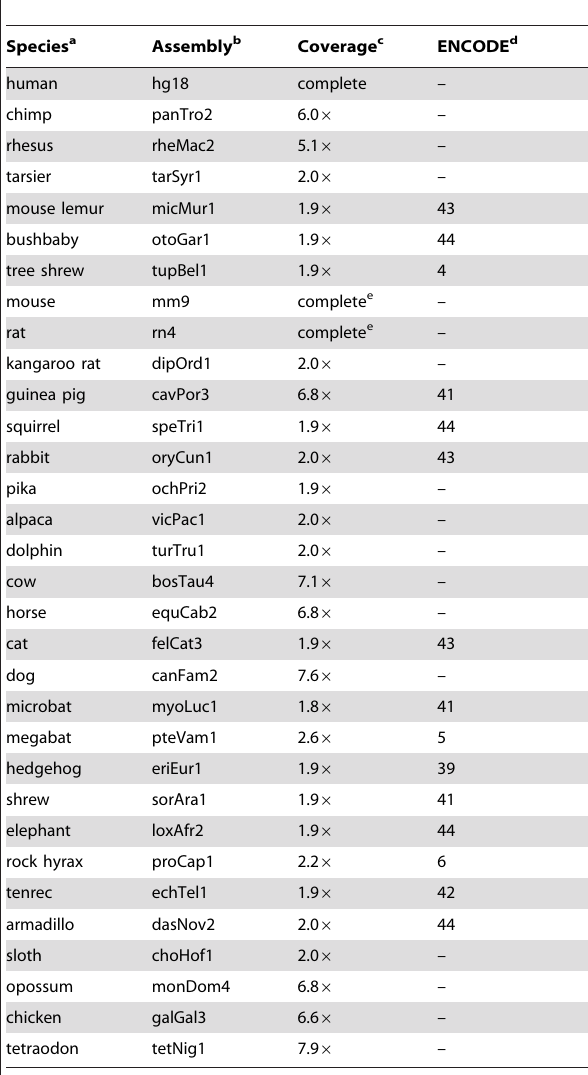
Table 1. Species and genome assemblies considered in this